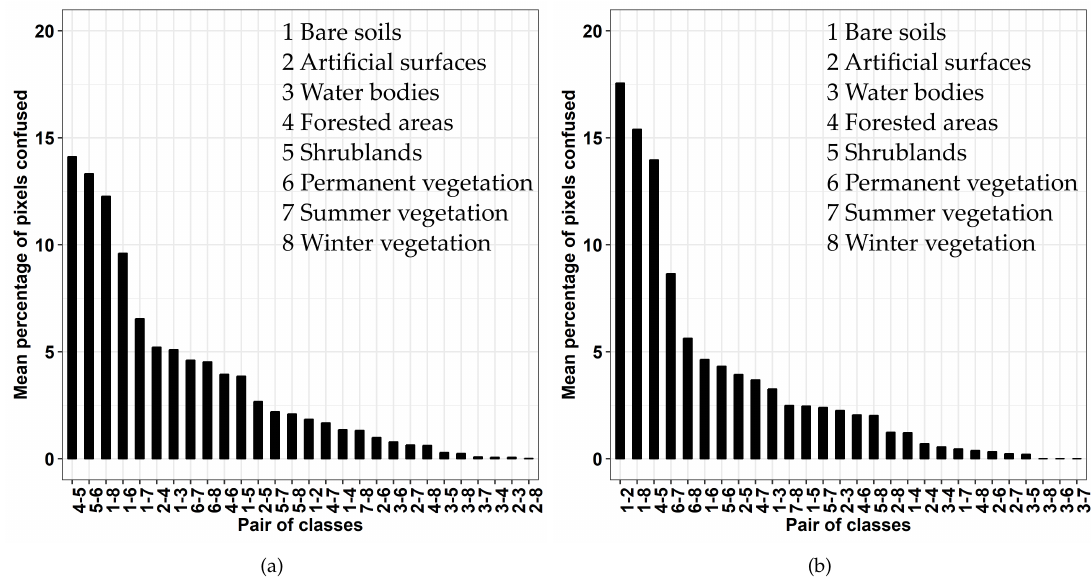
Figure 7. Mean percentage of pixels confused per pair of classes in relation to the total number of misclassified pixels using ( a ) the top 20 Sentinel-1 features and ( b ) the top ten Sentinel-2 features of the Spanish